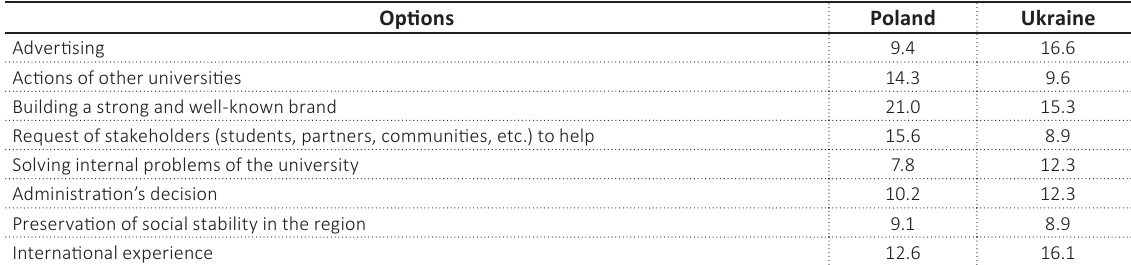
Table 7. Respondents’ answers to the question: What are the main reasons, in your opinion, encourage HEIs to implement the concept of social responsibility (multi-selection possible)?